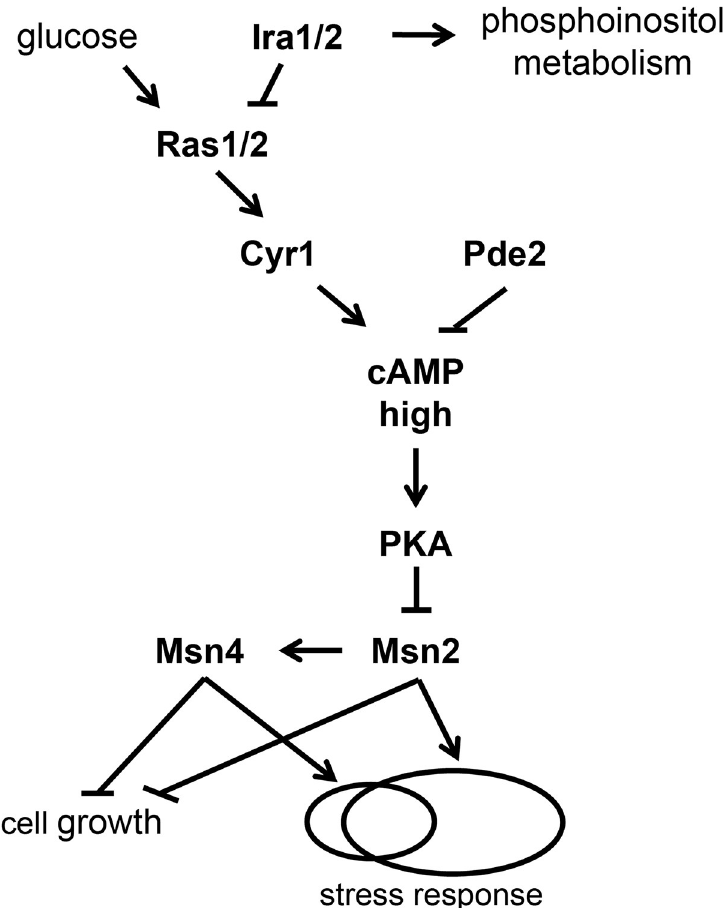
Fig 1. Standard model of the Ras/cAMP/PKA/Msn2/4 pathway. Under benign, glucose-replete conditions, the GTPases Ras1 and Ras2 exist predominantly in their GTP-bound form, which stimulates activity of the adenylyl cyclase Cyr1, thereby increasing intracellular cAMP concentration. Under glucose starvation, intracellular cAMP concentration decreases by virtue of the countervailing effects of the GTPase-activating proteins Ira1 and Ira2, which cause Ras1 and Ras2 to exist predominantly in their GDP-bound form, and the phosphodiesterases Pde1 and Pde2, which convert cAMP to AMP. Ira1 and Ira2 also positively regulate phosphoinositol metabolism independent of the Ras/cAMP pathway. cAMP activates PKA by relieving the inhibitory effect of Bcy1 (not shown). PKA phosphorylates both Msn2 and Msn4. The effect on Msn2 is to decrease its nuclear import and increase its nuclear export, rendering it less likely to activate its target genes, one of which is Msn4. Msn2 and Msn4 both repress cell growth and activate the stress response, but are not completely redundant and are therefore shown as regulating partially overlapping sets of stress-response target genes. See text for more